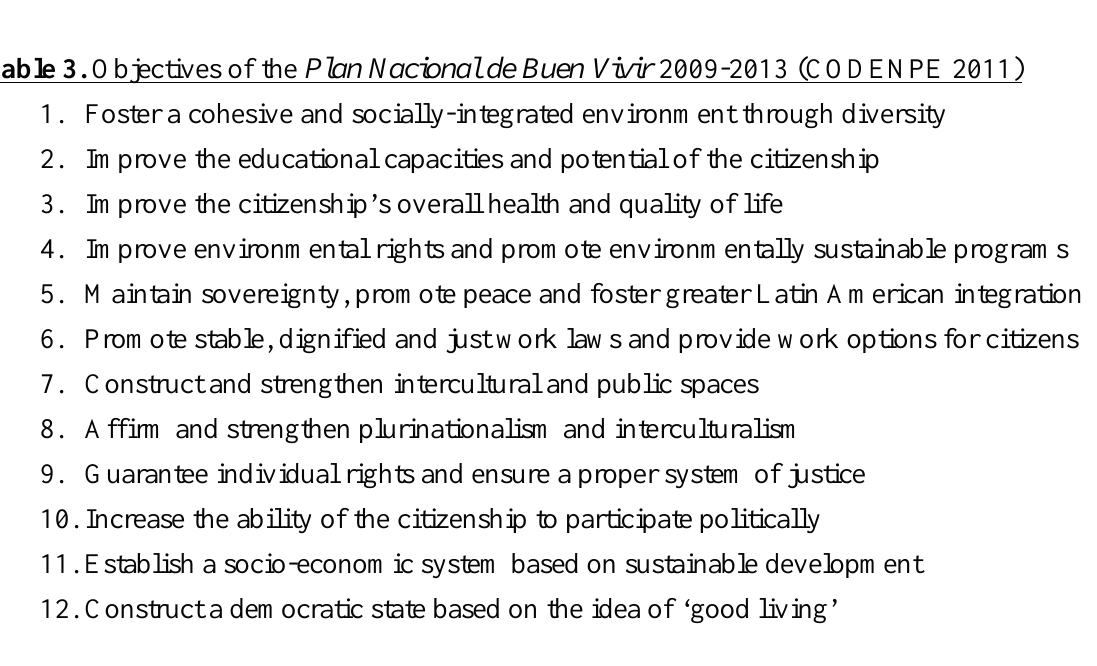
Table 3. Objectives of the Plan Nacional de Buen Vivir 2009-2013 (CODENPE 2011)